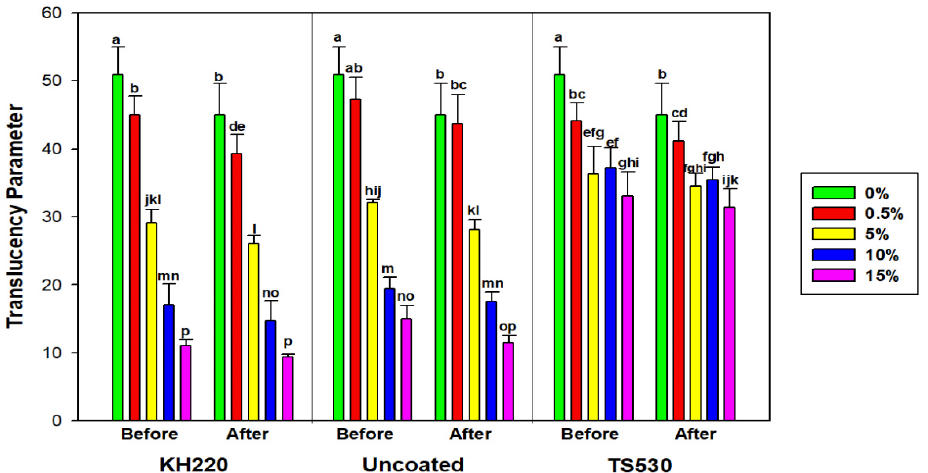
Figure 15. Bar graph displaying means and error bars representing standard errors of means for Translucency Parameter for Outdoor samples before and after 3000 h of weathering. Lower case letters denote statistical groupings. Groups with means having the same lower-case letters are not significantly different ( p > 0.05, ANOVA/Tukey). Comparisons are both within and across